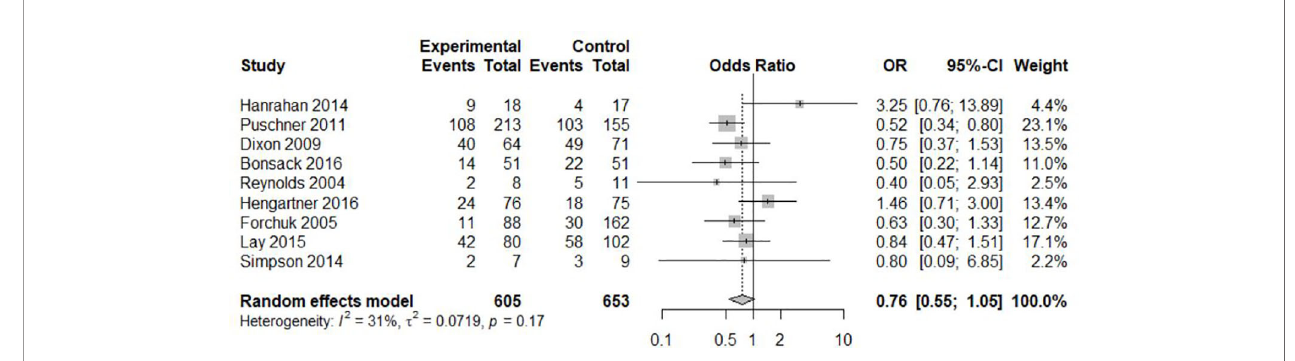
FIGURE 2 | Random effects meta-analysis for readmission.